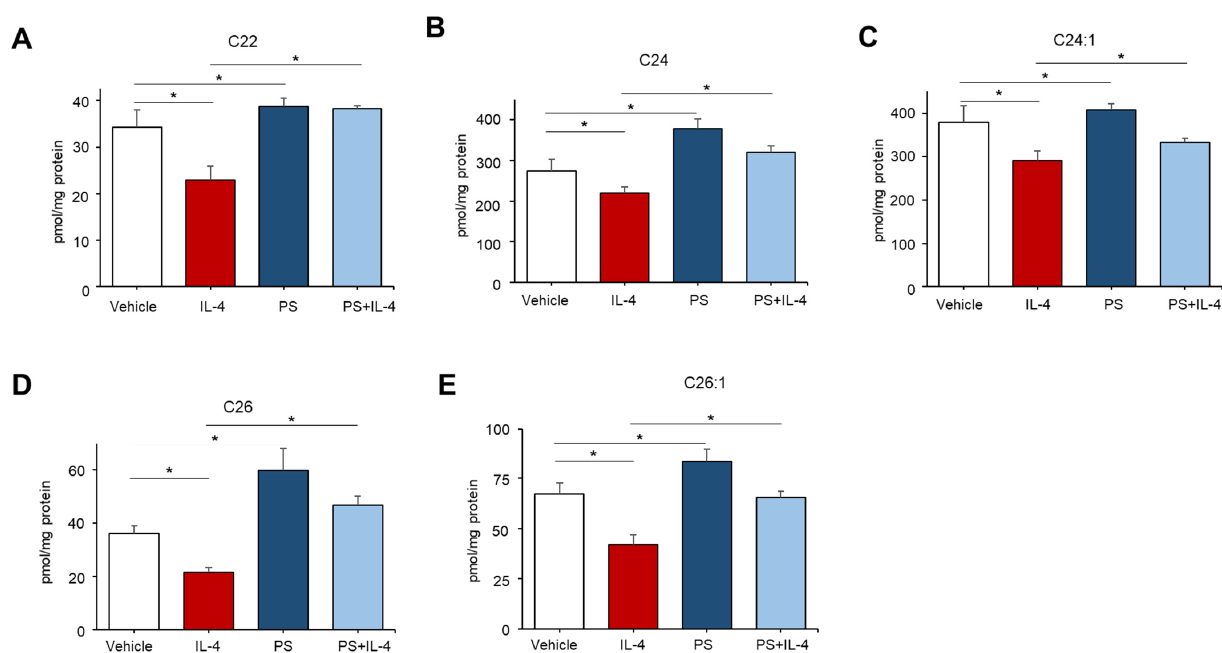
Figure 4. N-palmitoyl serinol (PS) specifically increases ceramides containing long-chain fatty acids (FA). HaCaT KC were Figure 4. N ‐ palmitoyl serinol (PS) specifically increases ceramides containing long ‐ chain fatty acids (FA). HaCaT KC were pretreated with IL ‐ 4 (50 ng/mL) for 20 h, followed by incubation with exogenous PS (25 μ M) for 4 h. Ceramides with pretreated with IL-4 (50 ng/mL) for 20 h, followed by incubation with exogenous PS (25 µ M) for 4 h. Ceramides with different different carbons in length (C22–C26, ( A – E ), respectively) were assessed by the LC ‐ MS/MS system. Statistical significance carbons in length (C22–C26, ( A – E ), respectively) were assessed by the LC-MS/MS system. Statistical significance was calculated was calculated using the unpaired Student’s t ‐ test, and significance was defined as * p < 0.01 vs. vehicle control (or using the unpaired Student’s t -test, and significance was defined as * p < 0.01 vs. vehicle control (or untreated untreated control).